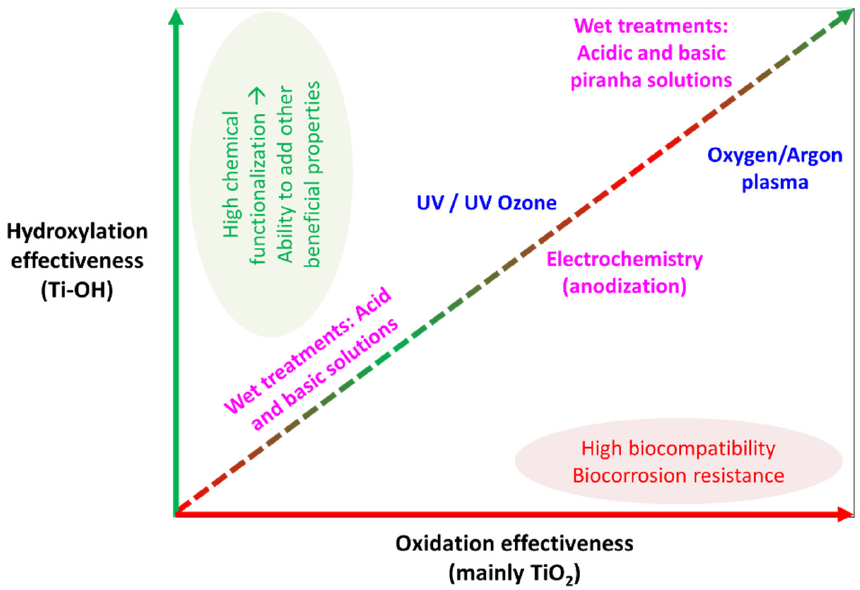
Figure 3. Graphic comparison of the surface hydroxylation and oxidation (TiOH/oxide ratio) effectiveness for each Ti surface activation method.